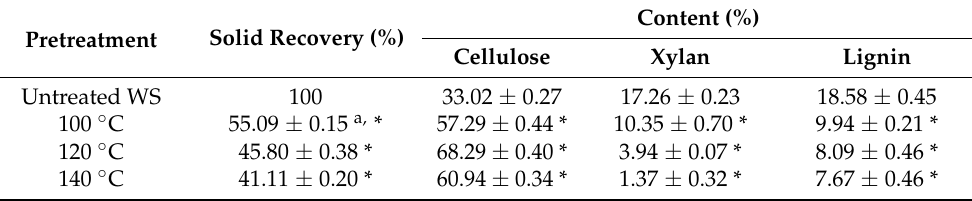
Table 1. Effects of different pretreatment temperatures on component contents of WS.